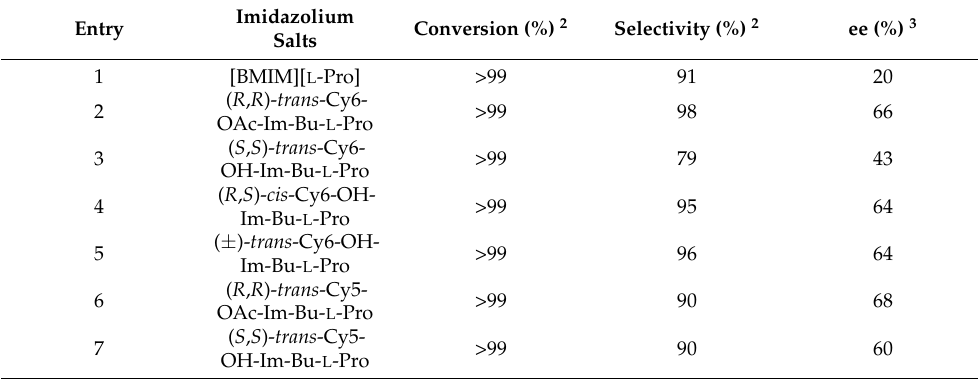
Table 3. Results for the aldol reaction between p -nitrobenzaldehyde and acetone- d 6 with different imidazolium L -prolinates (40% catalyst loading) at room temperature under solventless conditions 1 . Imidazolium Entry